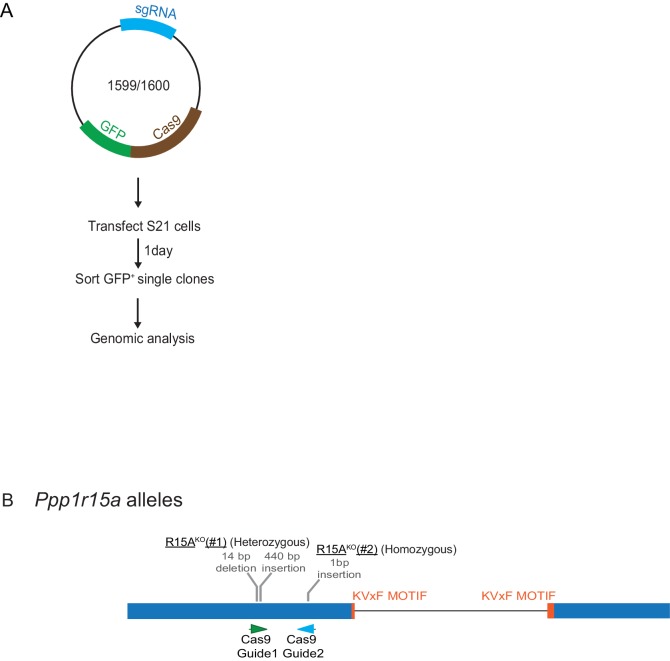
Mutant Ppp1r15a alleles.(A) Schema of the procedure to create dual reporter (CHOP::GFP, XBP1s::Turquoise) Ppp1r15aKO CHO-K1 cells using the CRISPR-Cas9 system. (B) Schema of the mutant alleles. The two coding exons of wildtype hamster Ppp1r15a are denoted as is the region encoding the crucial RVxF motif (KVHF, in PPP1R15A) and the positions of the guide RNAs used to direct the Cas9-mediated double strand breaks.